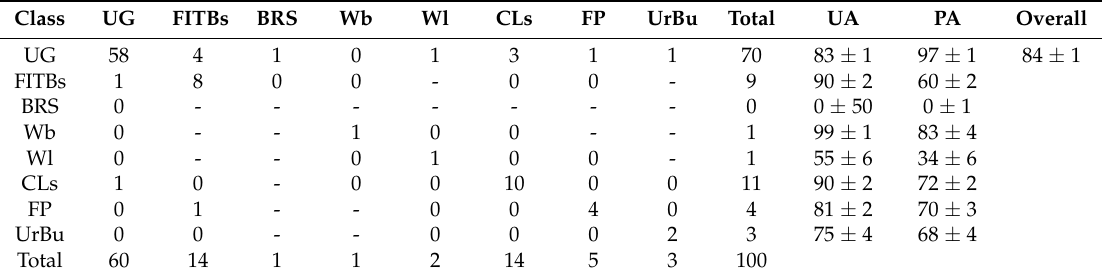
Table 5. Summarized accuracy assessment of ENLC 2000 (T1) expressed as the estimated proportion of